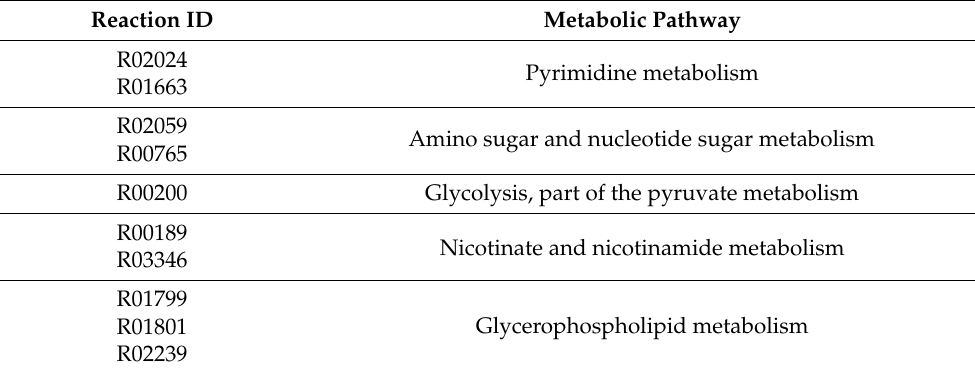
Table 4. Essential reactions of the m-DAG of